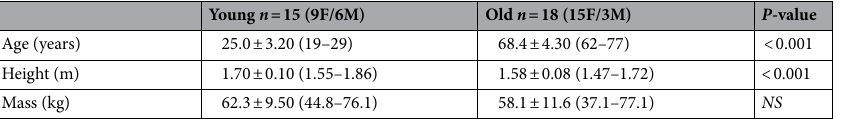
Table 1. Participant characteristics. Values are presented as mean ± SD (range). F female, M male, NS non- significant difference (P >